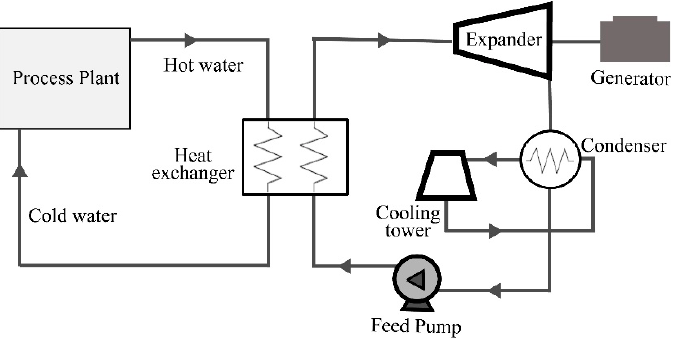
Figure 4. Schematic representation of the trilateral flush cycle.